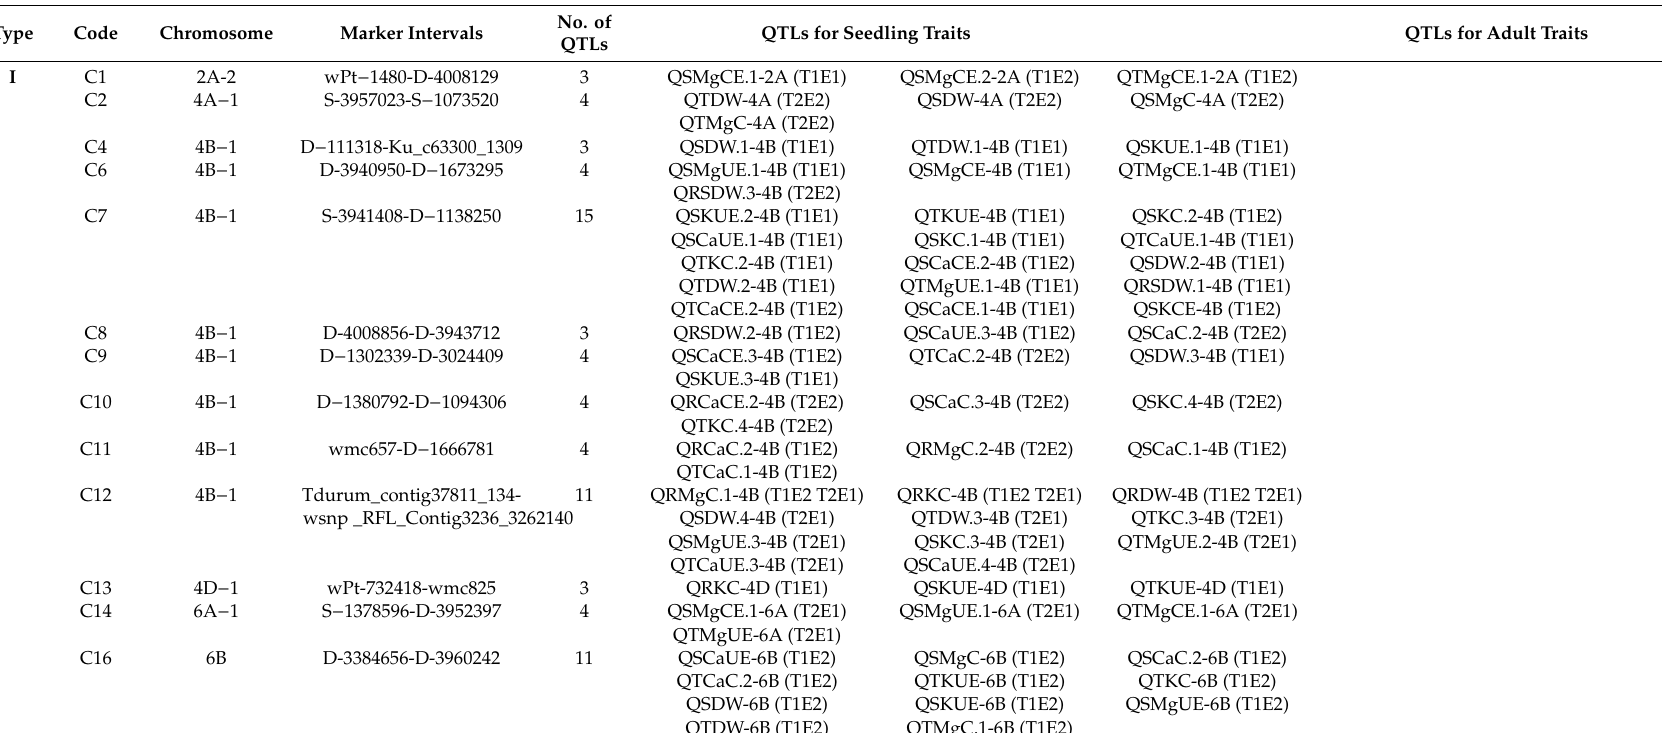
Table 5. Clusters comprising QTLs for more than two traits at seedling and mature